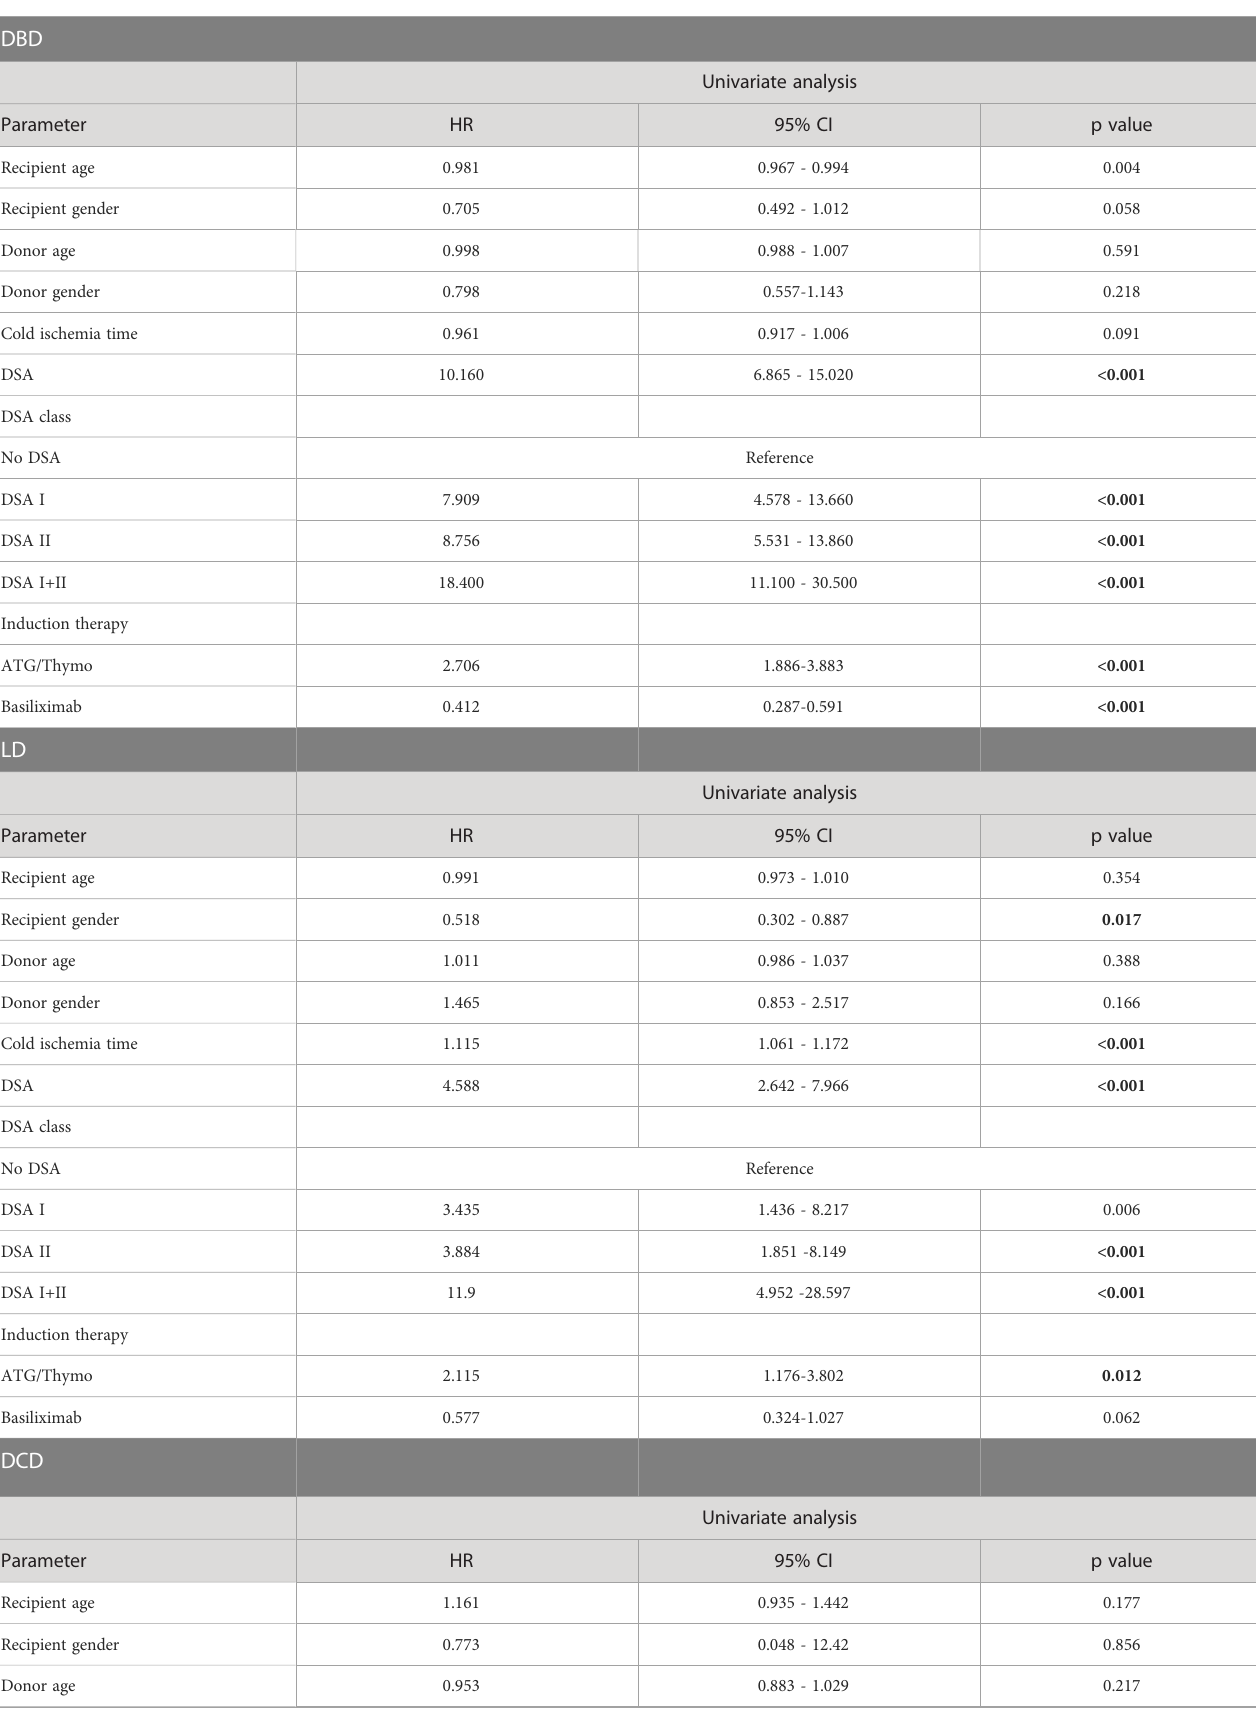
TABLE 3 Univariate analysis to identify potential predictors of